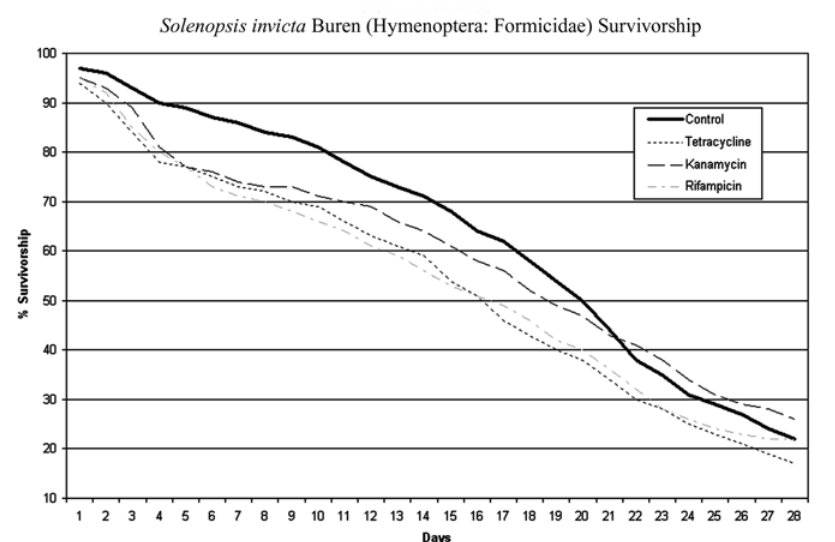
Fig. 4. survivorship curve of untreated and treated S.